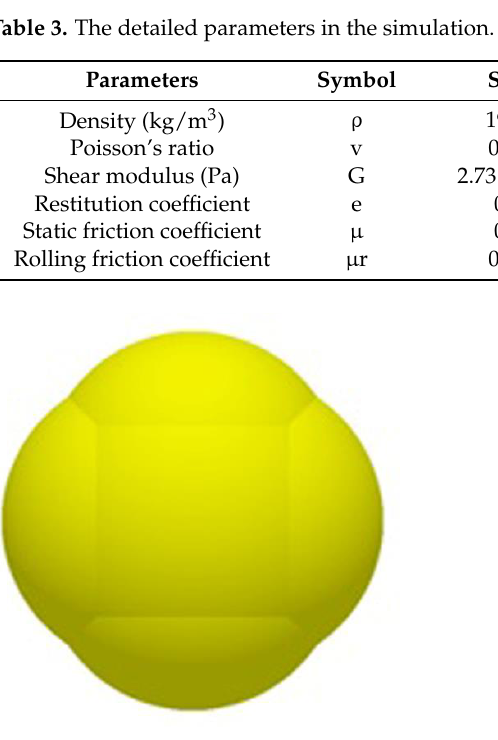
Table 2. Type of imposed constraint in the working process.